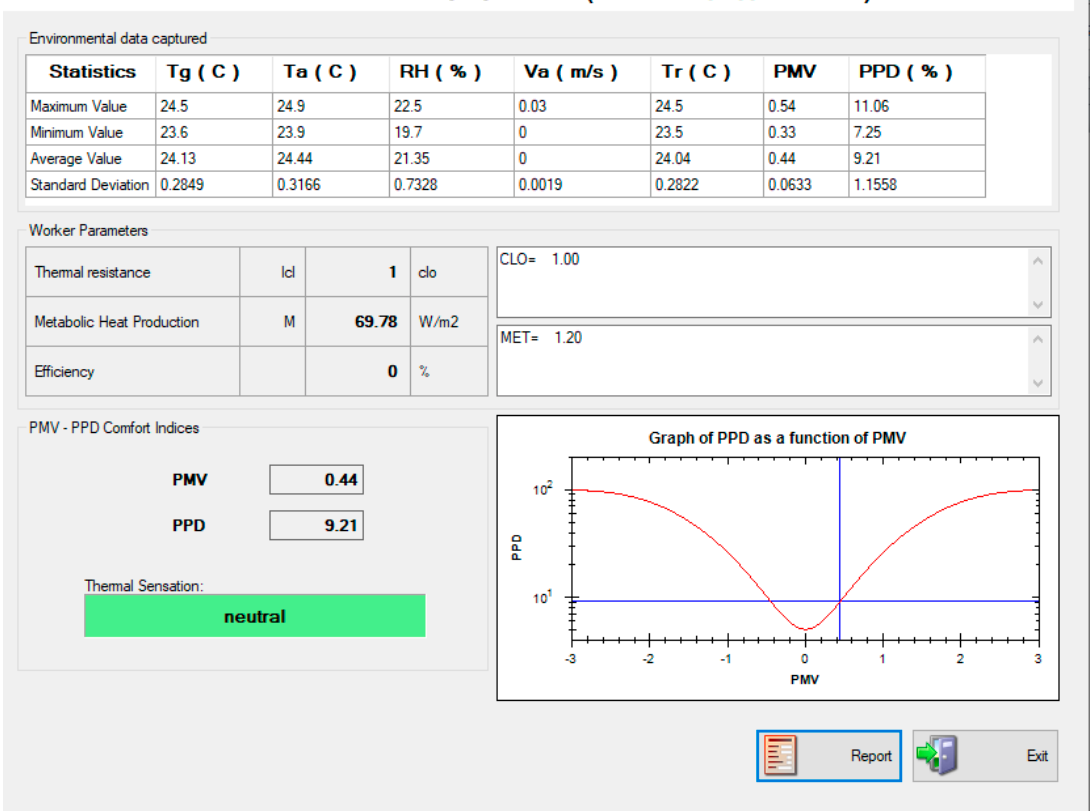
Figure A3. Screen capture of DeltaLog 10 software presenting the thermal sensation assessment based on PMV and PPD indices.